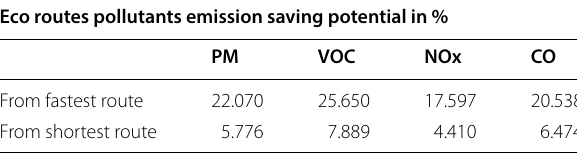
Table 9 Scenario 1 Case 3 eco route emission saving potential for each air pollutant accumulated